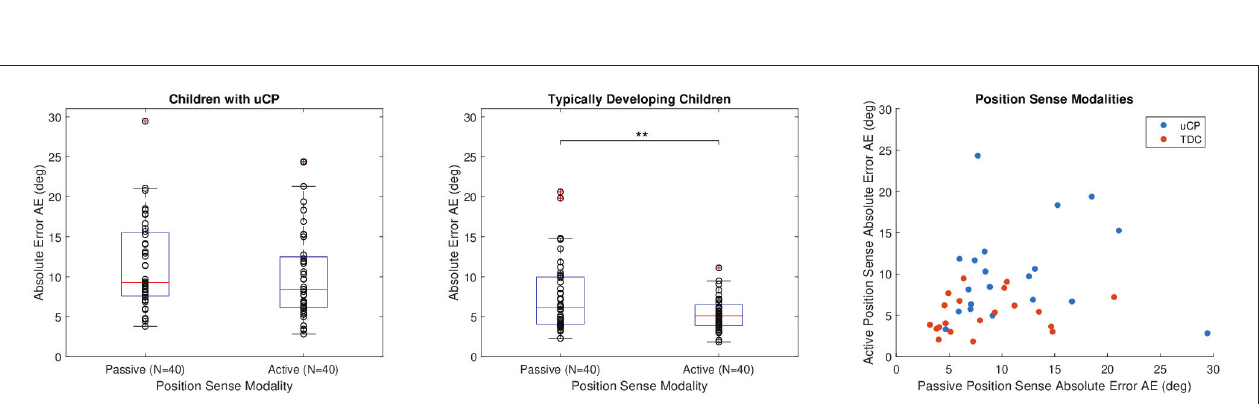
FIGURE 5 | Comparison between uCP and TDC in active and passive proprioceptive absolute error. The stars indicate the following significance: * < 0.05 and *** < 0.001. Data from both hands and both test sessions are considered together in the figure, hence N = 40. The smaller the absolute error AE the better the performance (higher acuity).